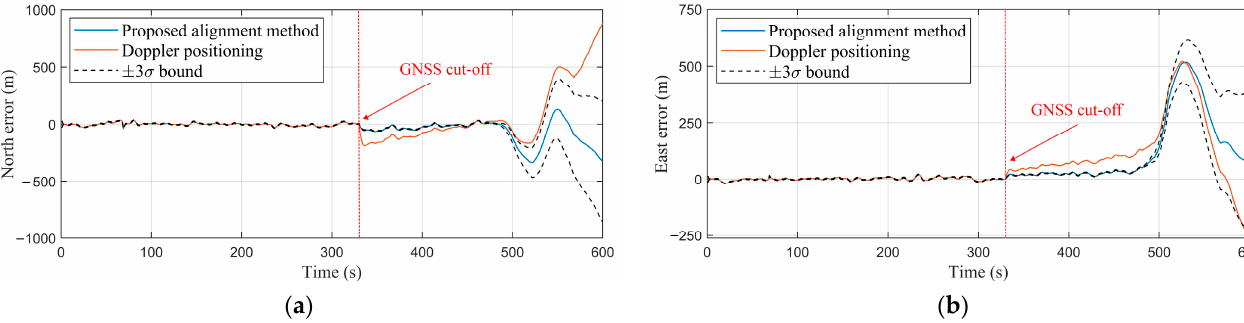
Figure 16. The North ( a ) and East ( b ) position errors of the aircraft before and after blocking the GNSS compared with the error of the Doppler positioning method. Table 2. RMSE of the alignment method for different time slots from the start point compared with the error of the Doppler positioning method.